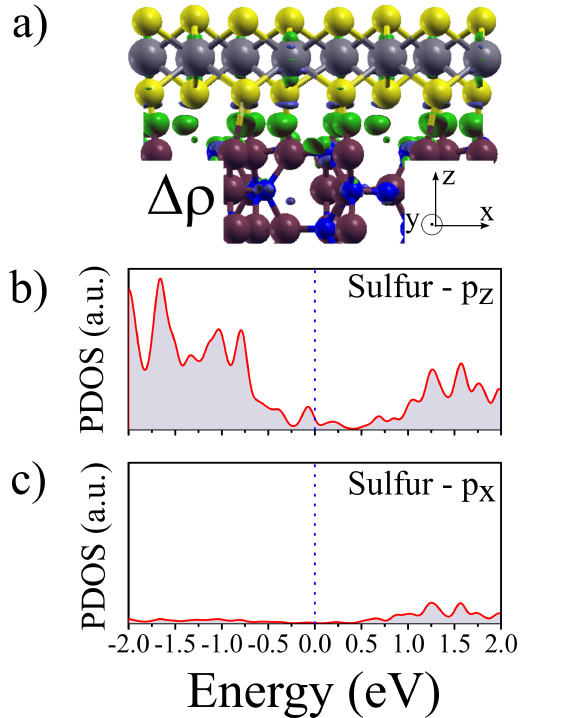
Figure 5. ( a ) Charge difference ∆ ρ exchanged between WS 2 and Si 3 N 4 substrate. ( b ) PDOS for the sulphur pz orbitals populating around the Fermi level. ( c ) px from sulphur showing no reactivity for energies nearby E F , thus indicating that the in plane bonds are still